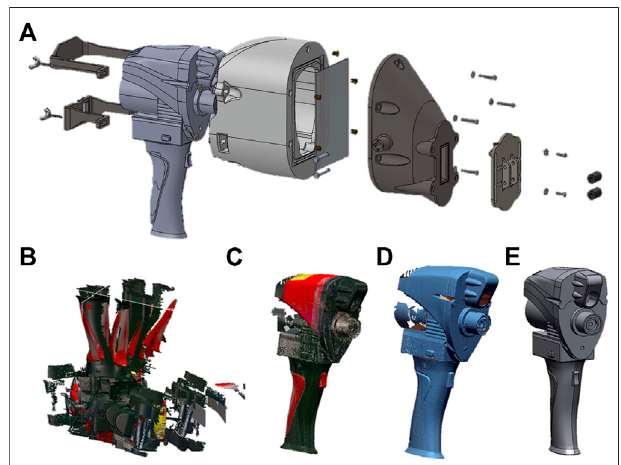
FIGURE 4 | (A) test device: (from left to right) blocks for axis fi xing, RS1 probe, head rear part, screen glass, head front part, rollers seat, idle rollers; (B) NextEngine scans imported to Geomagic ® Design X ™ ; (C) combine the various scans of the RS1 probe through the “ volume merge ” function; (D) texture elimination; (E) CAD geometry modelling of the